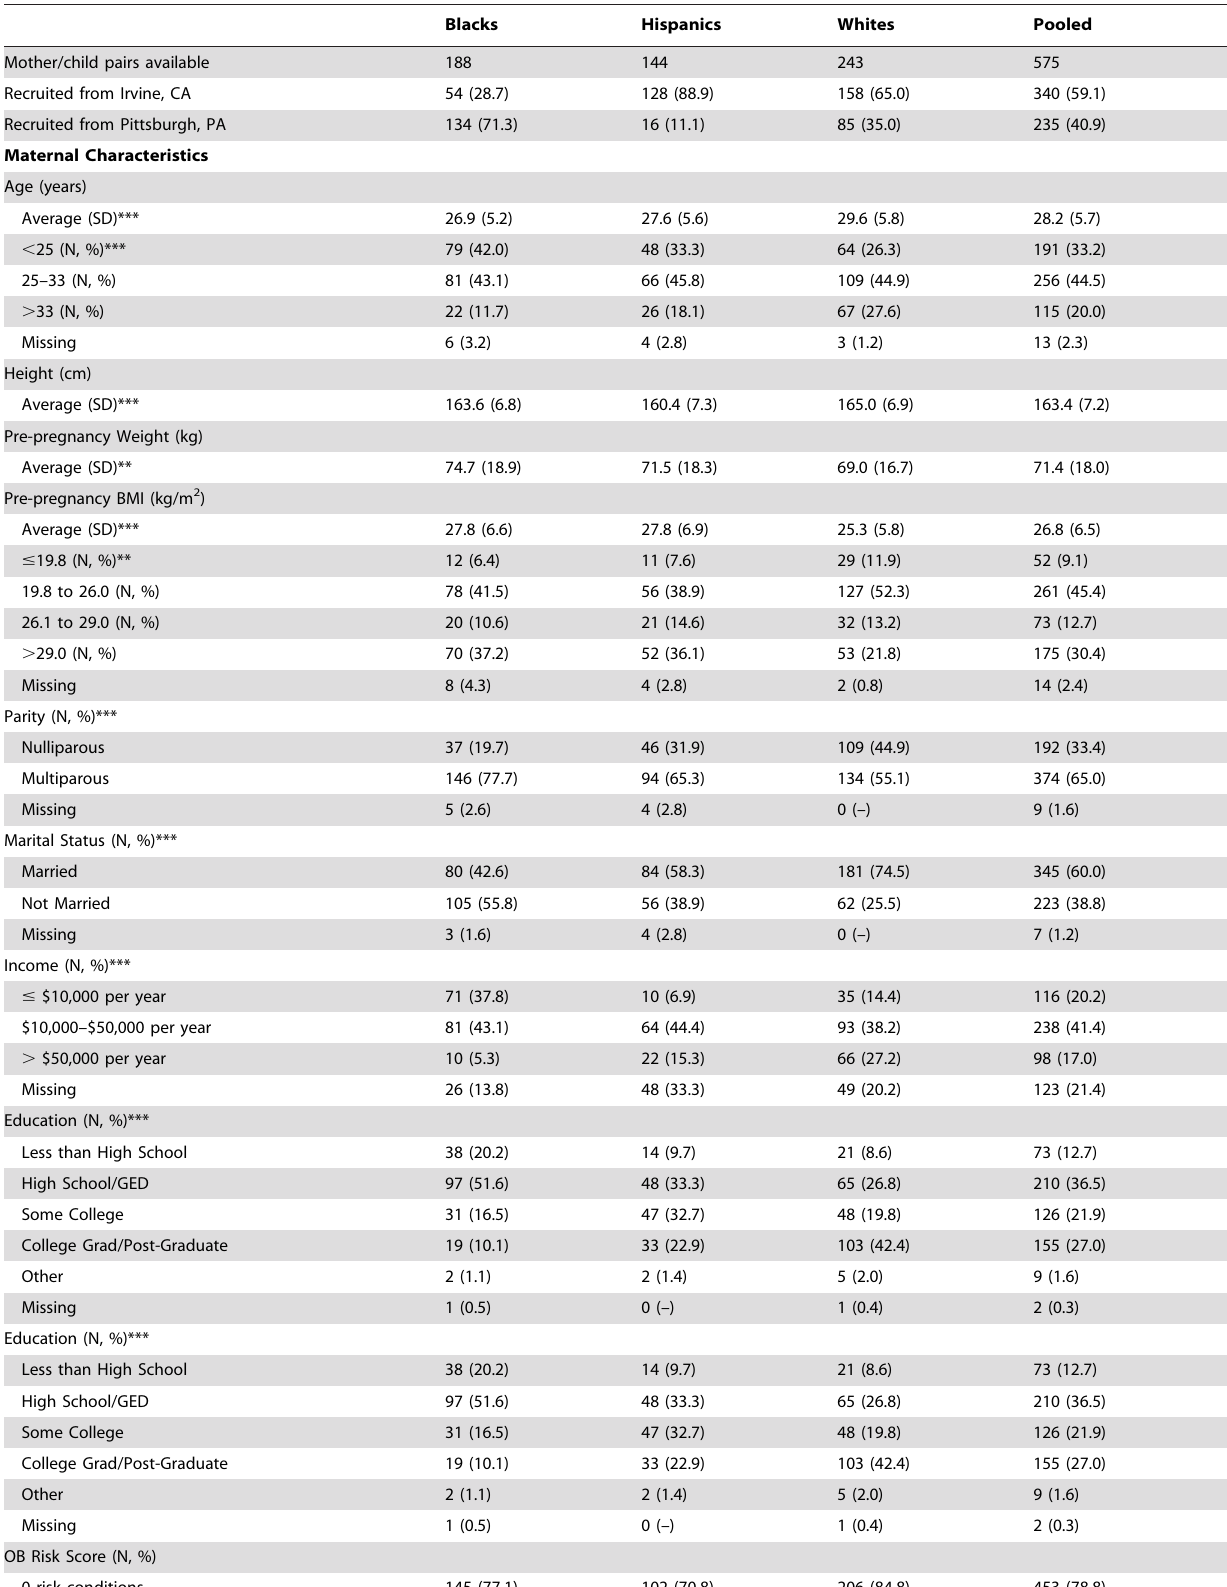
Table 1. Subject characteristics.